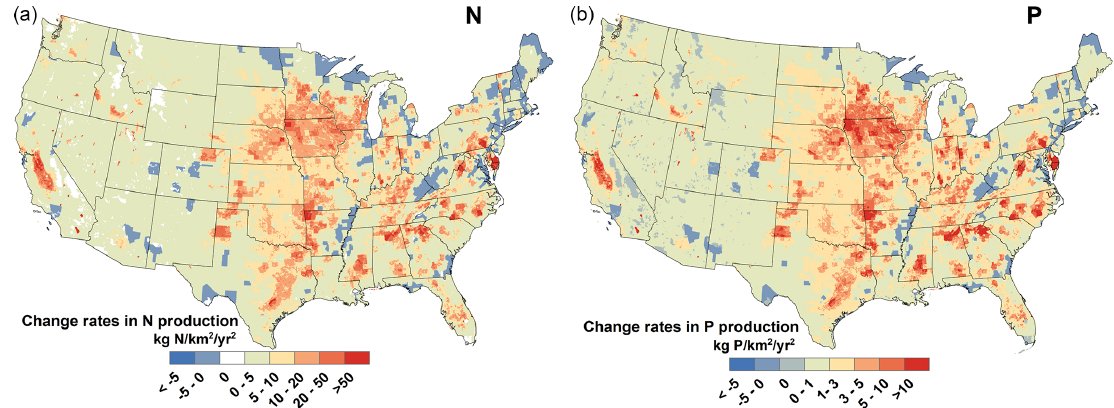
Figure 4. Change rates of manure (a) N and (b) P production across the contiguous US during 1860–2017. (Note: the increasing rates were calculated based on the Mann–Kendall